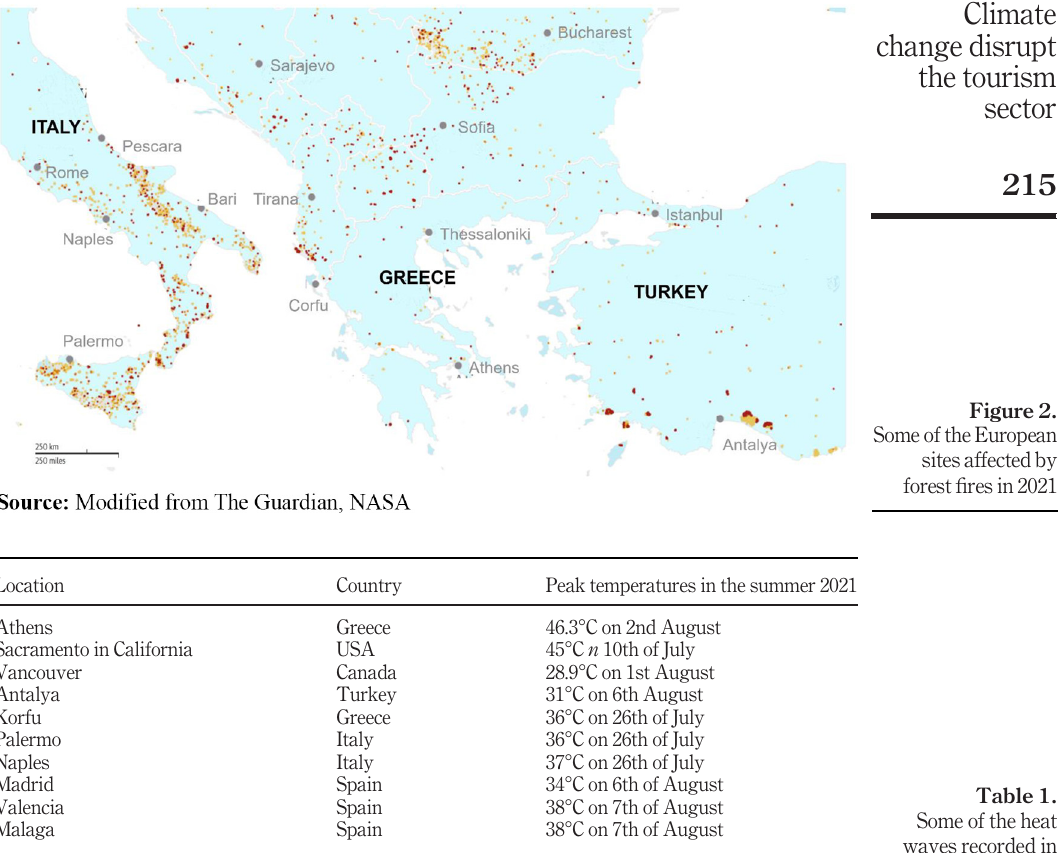
waves recorded in